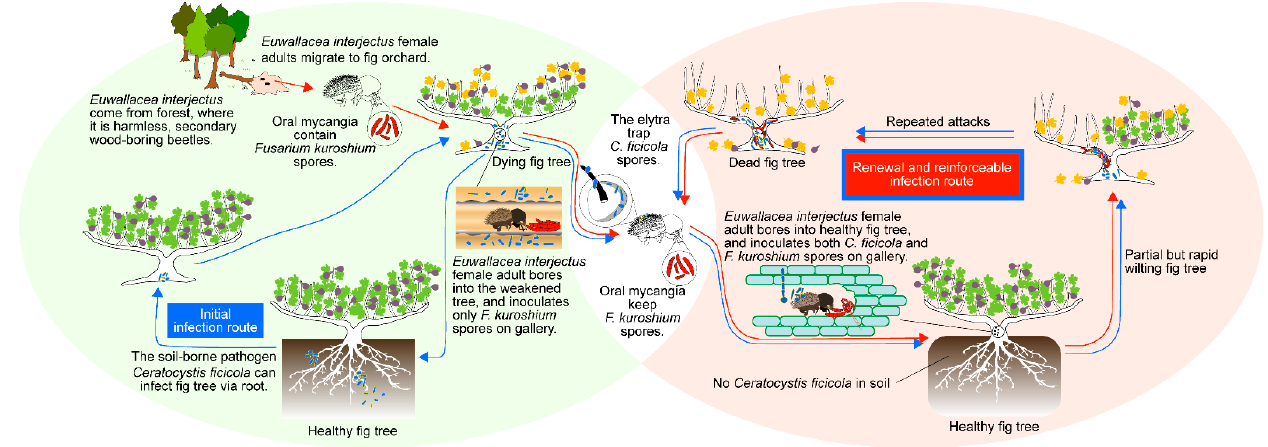
Figure 6. A schematic model for system changes of symbiosis among Euwallacea interjectus and its associated fungi in fig wilt disease.